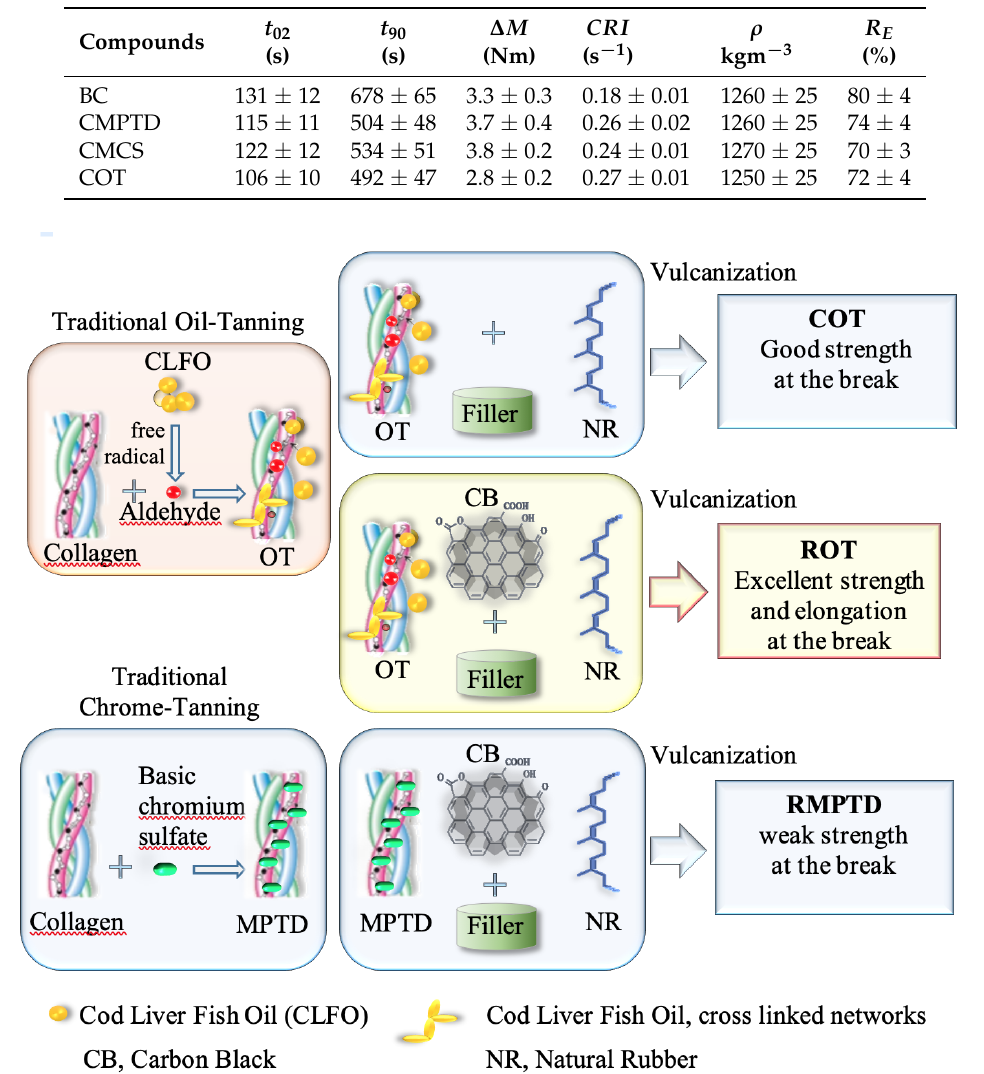
Table 3. Characteristic parameters of vulcanization curves of rubber compounds obtained from leather waste. Experimental error for each value is calculated as standard deviation of repeated measurements.